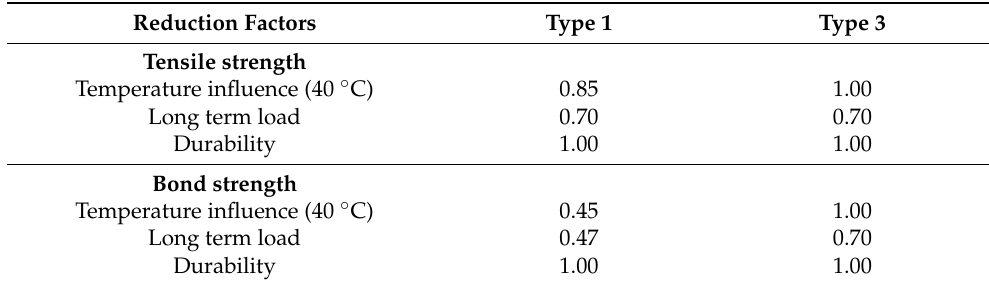
Table 4. Reduction coefficients for temperature exposure (40 ◦ C), continuous exposure and chemical exposure, according to